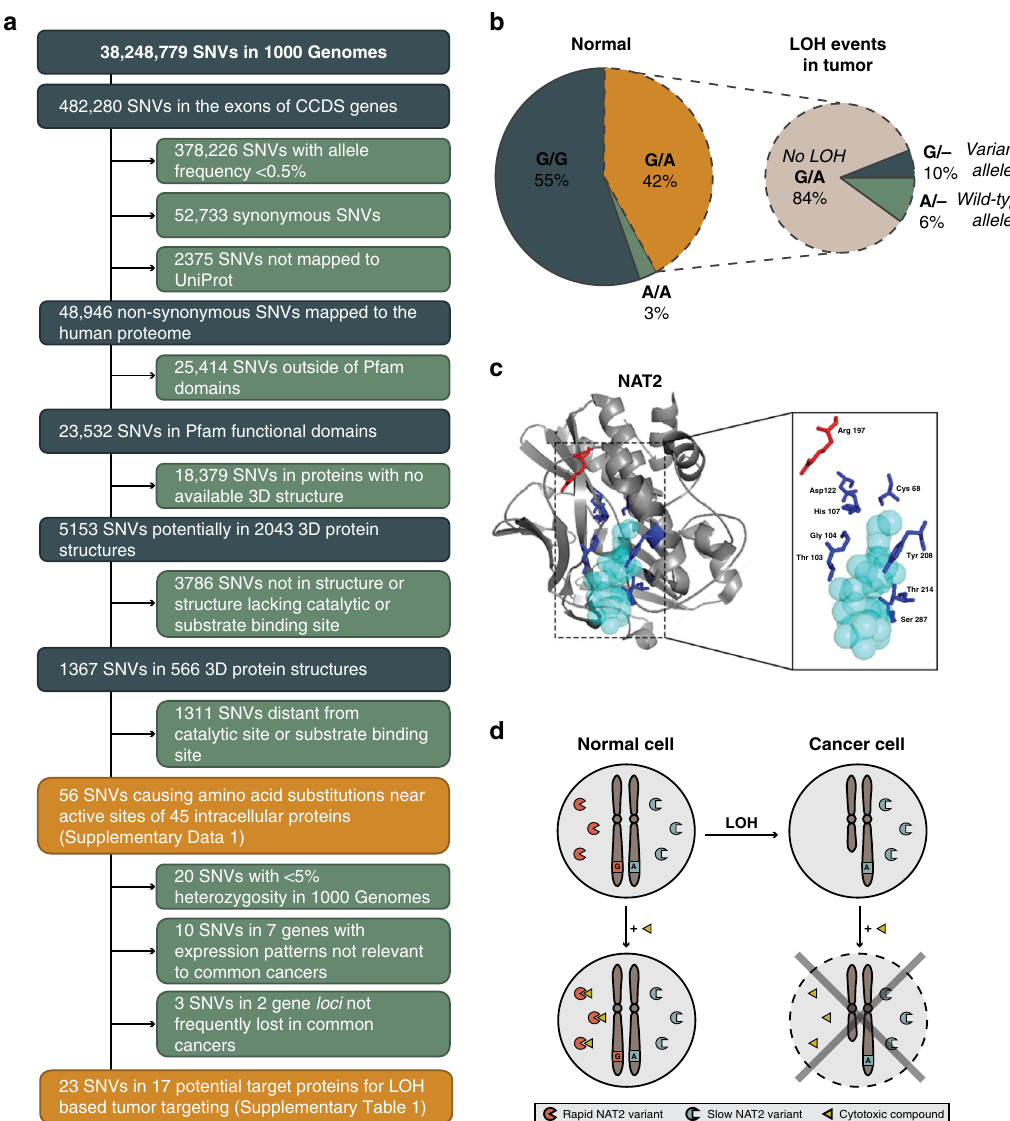
Fig. 1 N-acetyltransferase 2 (NAT2) is a target for allele-speci fi c inhibition. a Identi fi cation of enzymes with prevalent alternative alleles resulting in amino-acid substitution near functional sites. A series of fi ltering steps was applied to identify the subset of SNVs causing amino-acid substitutions near active sites in publicly available 3D protein structures. To enrich potential target proteins for LOH-based tumor targeting approaches, the candidate genes were further selected based on expression pro fi le and the frequency of LOH in common cancer types. b Loss of heterozygosity at 8p22 can render CRCs de fi cient in NAT2 function. To con fi rm the prevalence of rs1799930 and the frequency of LOH at NAT2, genomic DNA from 74 CIN CRCs and patient- matched normal tissues was genotyped. Left, genotype distribution of normal tissues. Right, LOH events observed in the tumors of heterozygous individuals. c Structure of human NAT2 co-crystallized with the cofactor coenzyme A (light blue) (PDB: 2PFR). The side chains of the active site amino-acid residues involved in substrate transformation (Asp122, Cys68, and His107) and cofactor binding (Gly104, Thr103, Thr214, Tyr208, and Ser287) (dark blue) and the side chain of Arg197 (rs1799930, red) are shown. The fi gure was designed in PyMOL (v. 2.3.2). d Exploiting loss of a rapid NAT2 allele in tumor cells for anti-cancer therapy. Eligible patients are heterozygous for the slow (A, blue) and rapid (G, red) NAT2 alleles. During cancer progression, cancer cells may undergo loss of heterozygosity (LOH) and lose the rapid NAT2 allele (red). Treatment with a cytotoxic compound (triangle) that can only be processed by the rapid NAT2 enzymatic variant lost in cancer cells will result in selective tumor